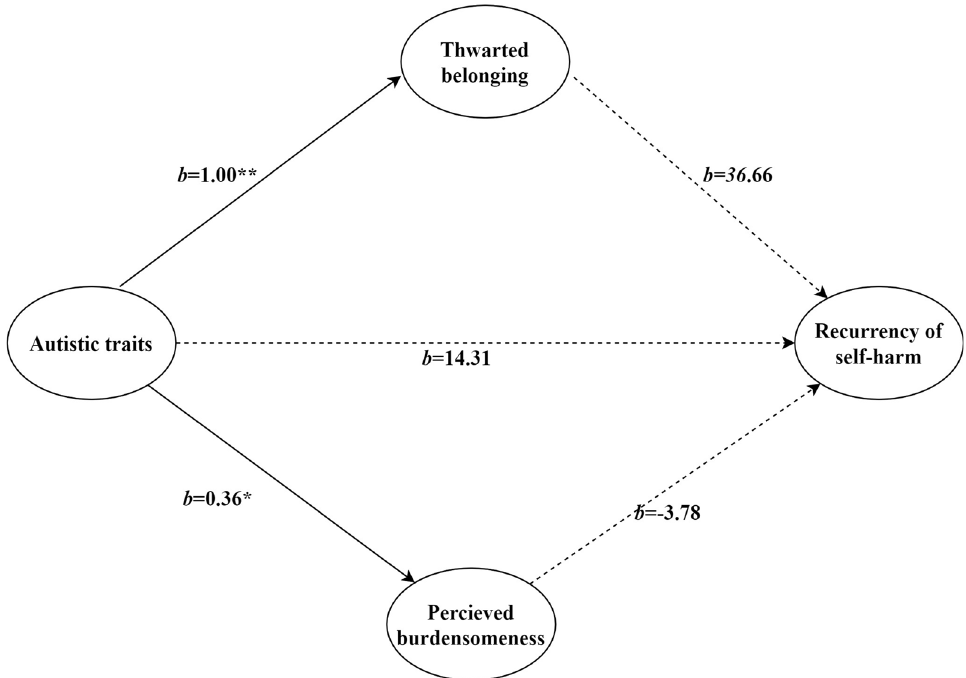
Fig. 1 The connection between autistic traits and the recurrence of self-harm mediated by IPTS